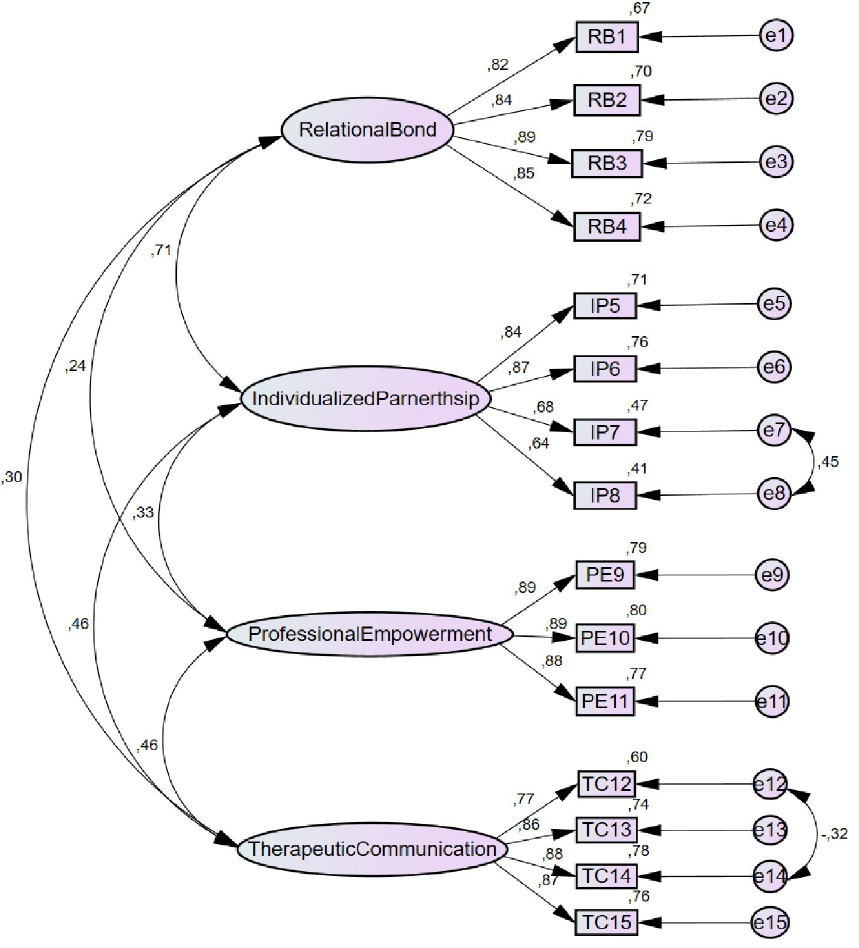
Fig 1. Confirmatory factor analysis of the four-dimensional model of the PCTR-PT.